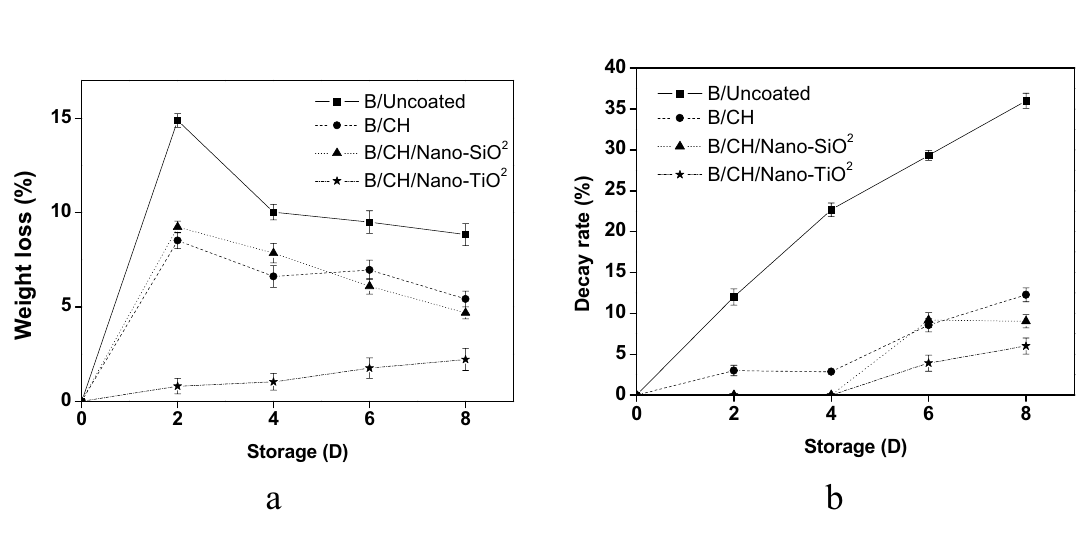
Figure 1. Films preparation.